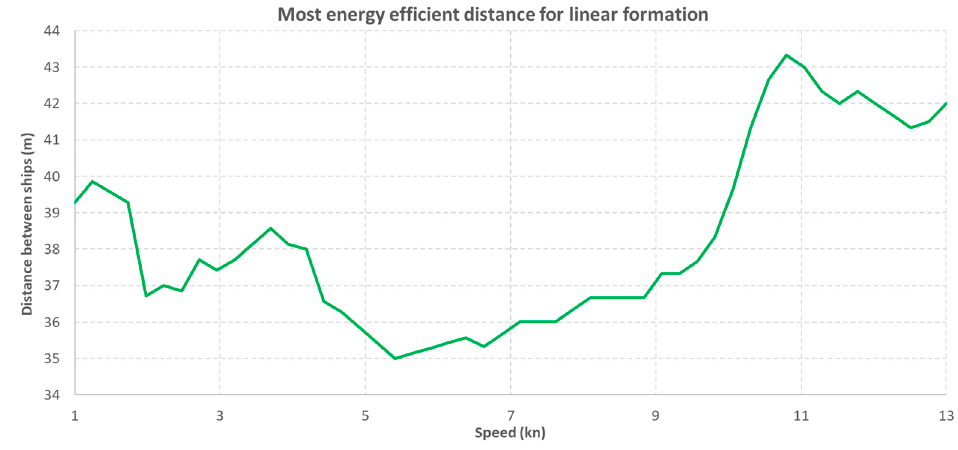
Figure 18. Distance providing the least resistance for a given formation speed in a linear formation.